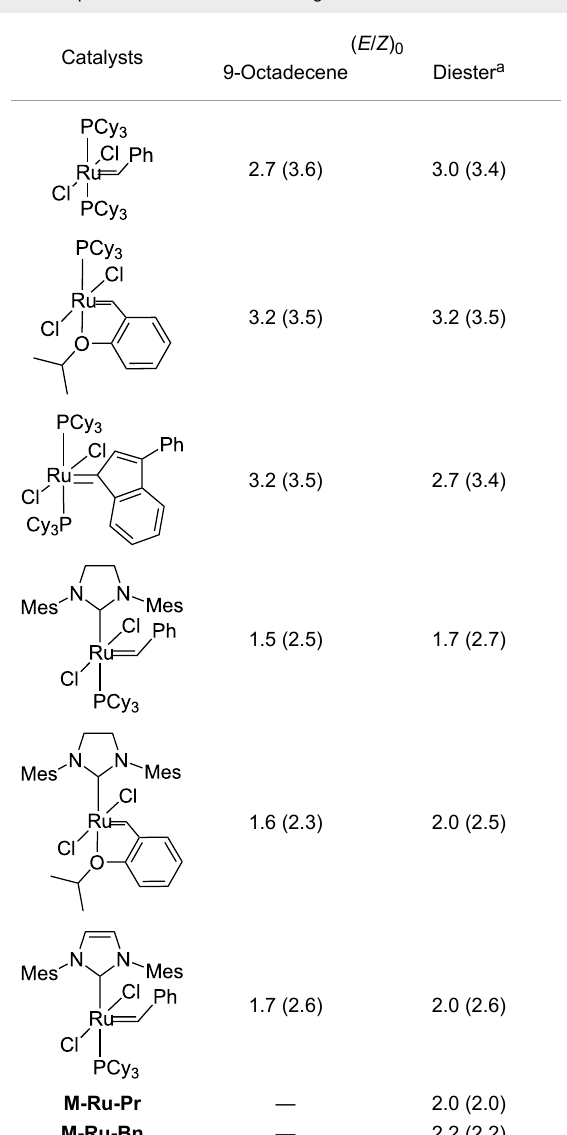
Table 3: Stereoselectivity of Ru–NHC catalysts. Comparison of molec- ular complexes and materials containing Ru–NHC units.